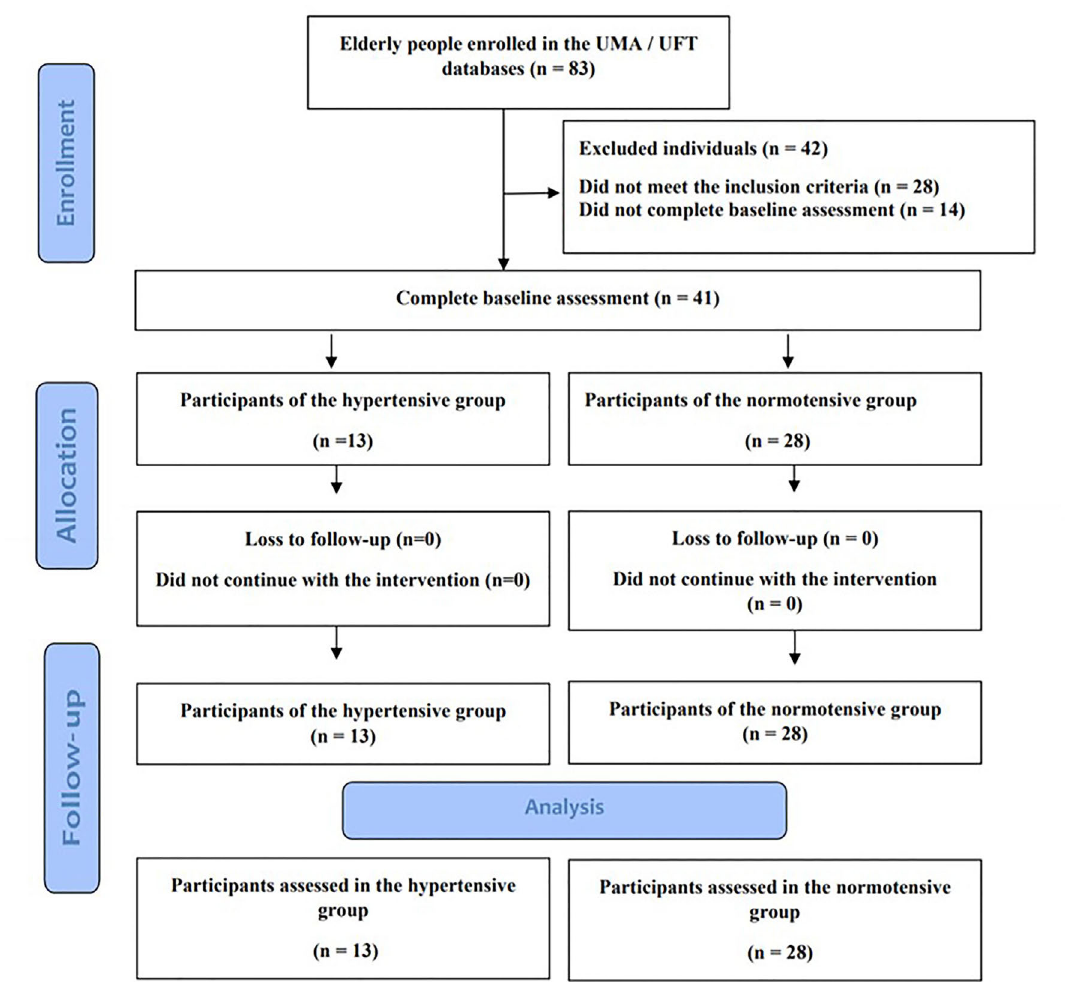
Figure 1 - Flowchart of